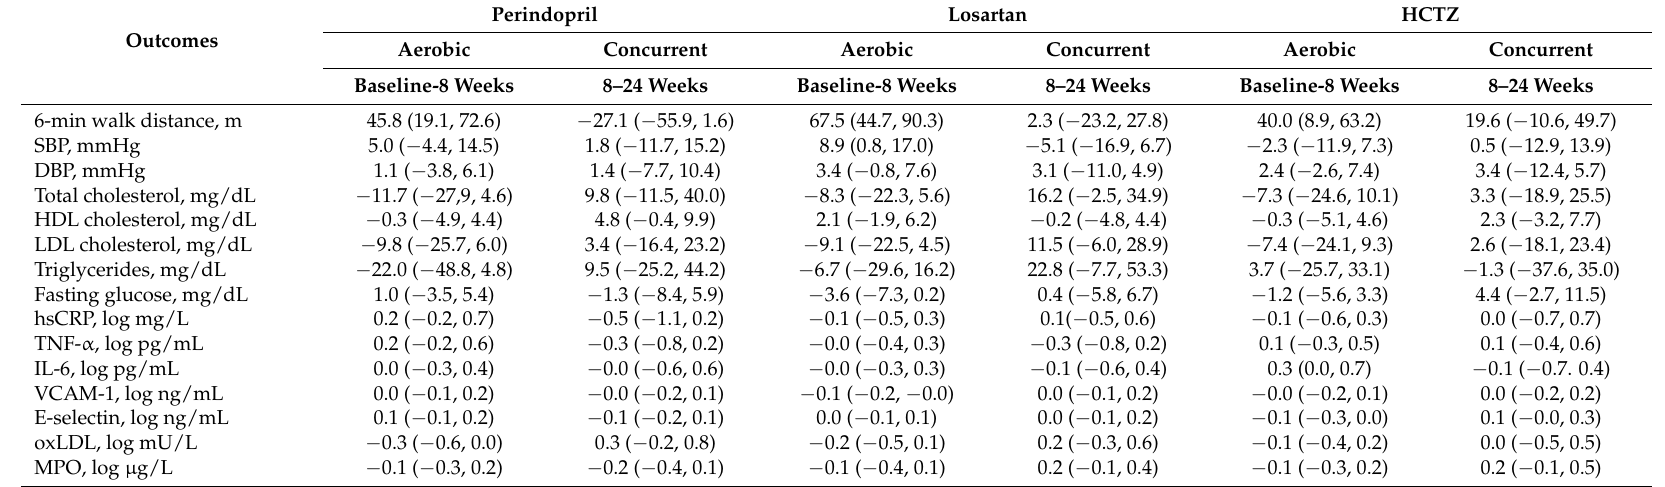
Table 2. Change within groups in secondary outcomes according to exercise mode